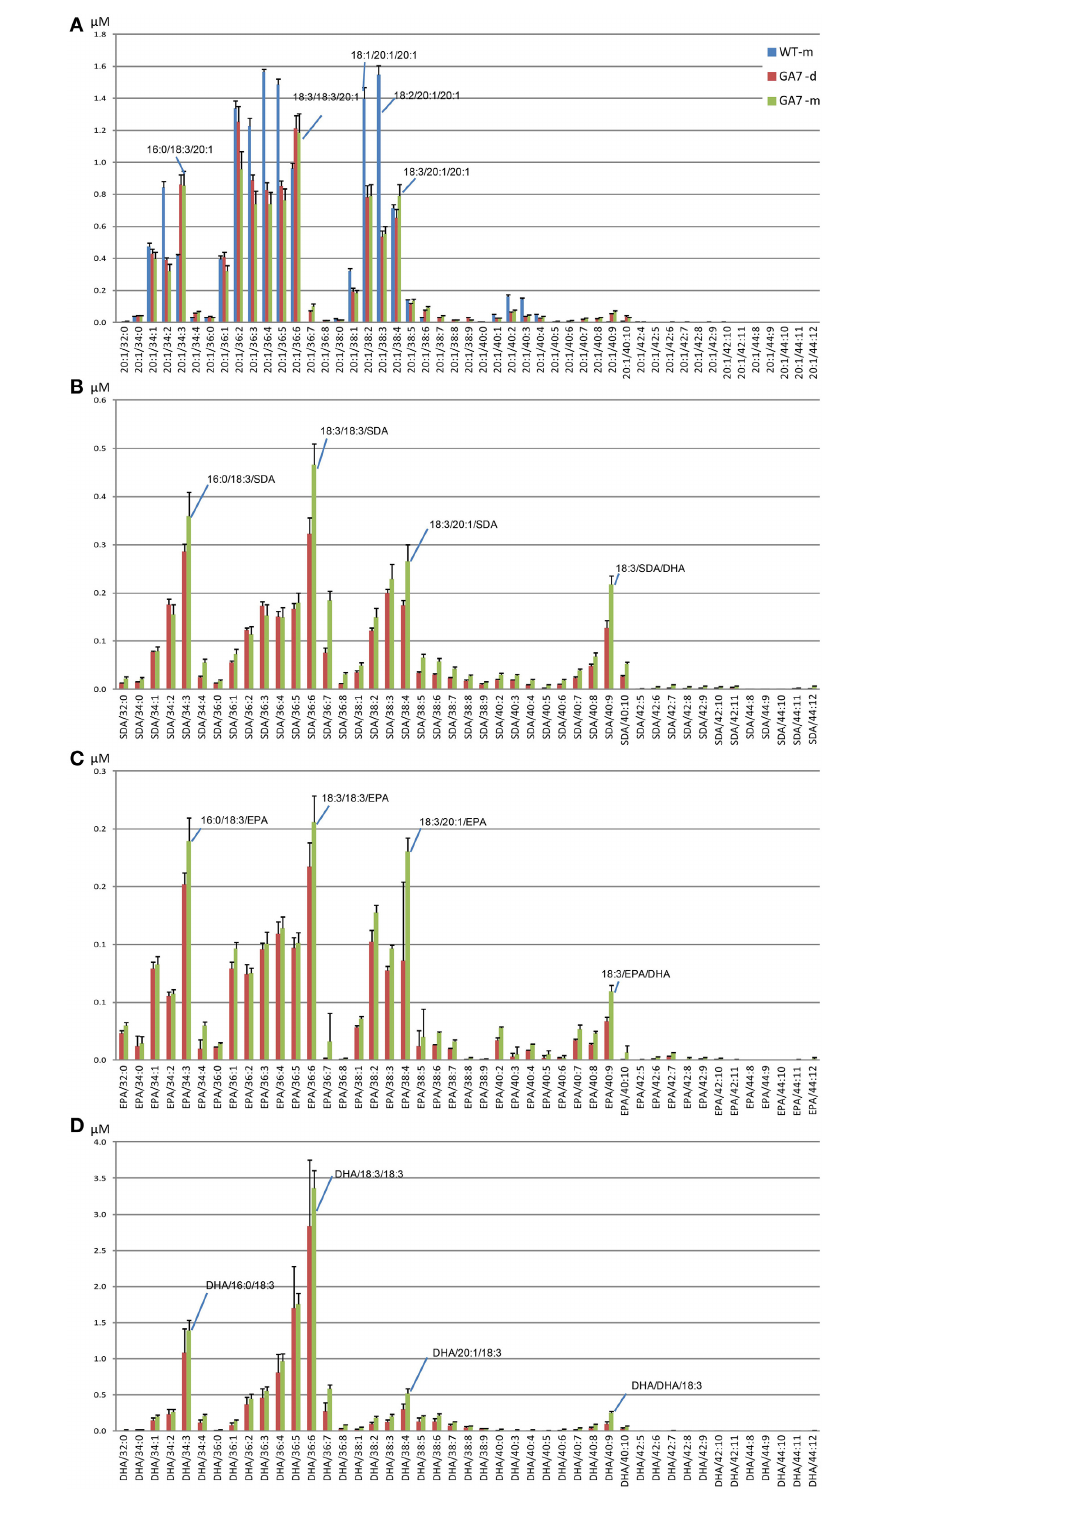
containing X number of total carbons and Y number of total double bonds. Data are shown as the mean of triplicate analysis with the error bars representing the standard deviations. Predominant TAG species within the subgroups are